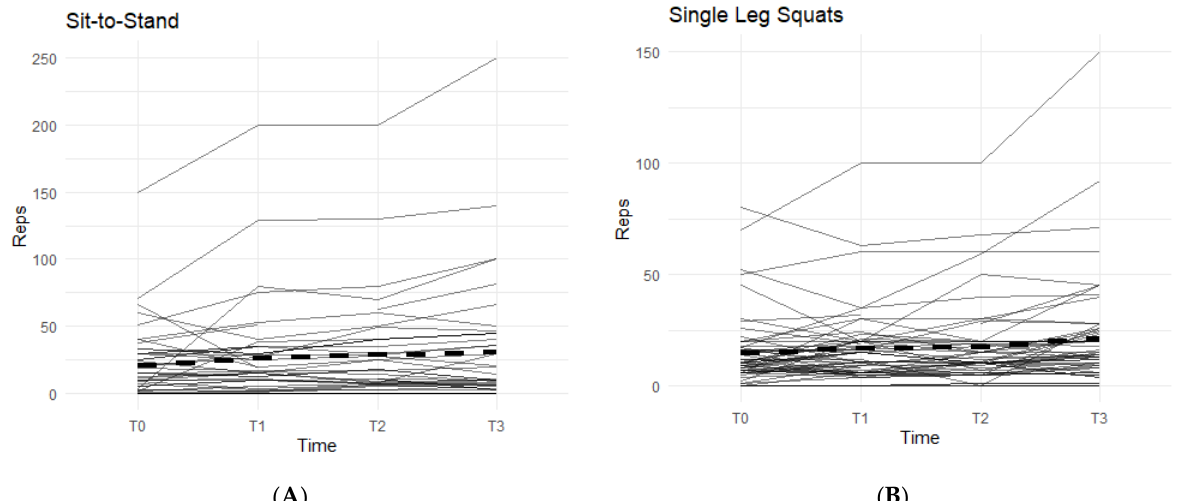
Figure 3. Sit-to Stand and Single-Leg Squats Changes Over Time During the Study Period. The figures show the changes in total repetitions of sit-to-stand squats and single-leg squats. Only the results for the affected knees were included. Solid lines represent individual participant scores. Thick dashed lines represent group averages. ( A ) shows reps of sit-to-stand squats from T0–T3. ( B ) shows reps of single-leg squats from T0–T3.